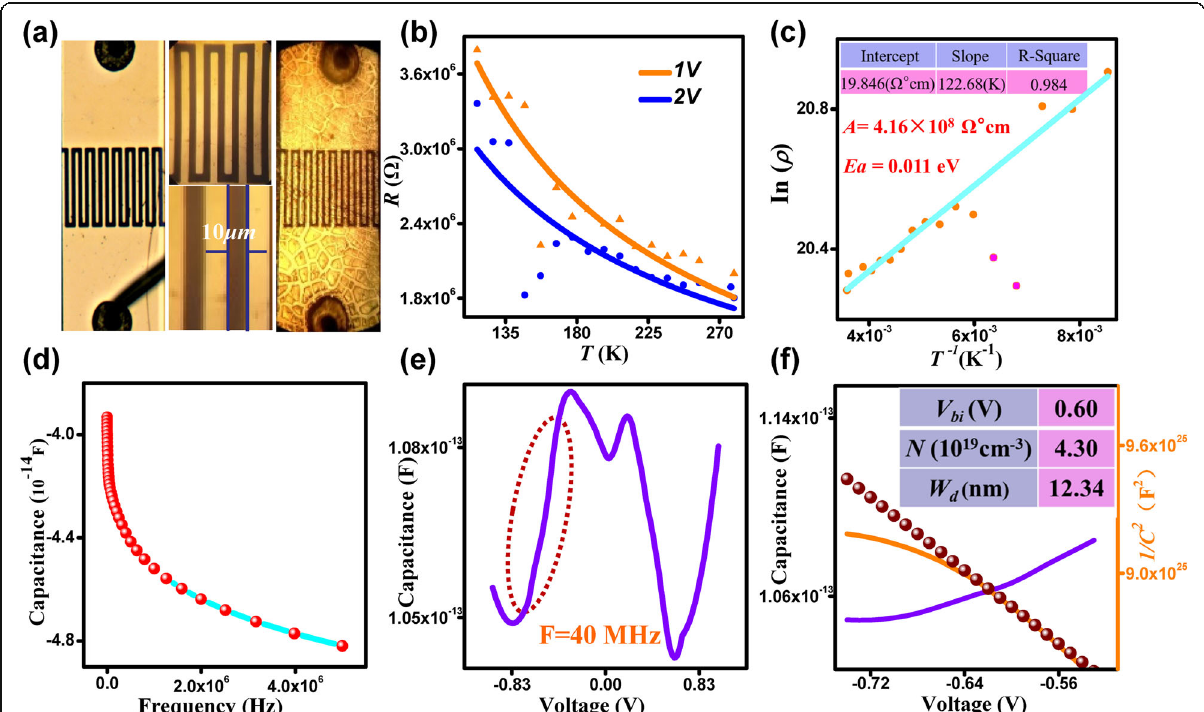
Fig. 4 a Photodetector with In 2 S 3 QDs as an active layer. b Plot of R-T at 1 V and 2 V. c Plot of ln ( ρ )-1/T- based devices at 1 V. d C-F curves measured at room temperature. e The C-V curves (40 MHz)-based photodetector in the dark condition. f Variation of the capacitance with applied voltages and plots of 1/C 2 vs . V of the